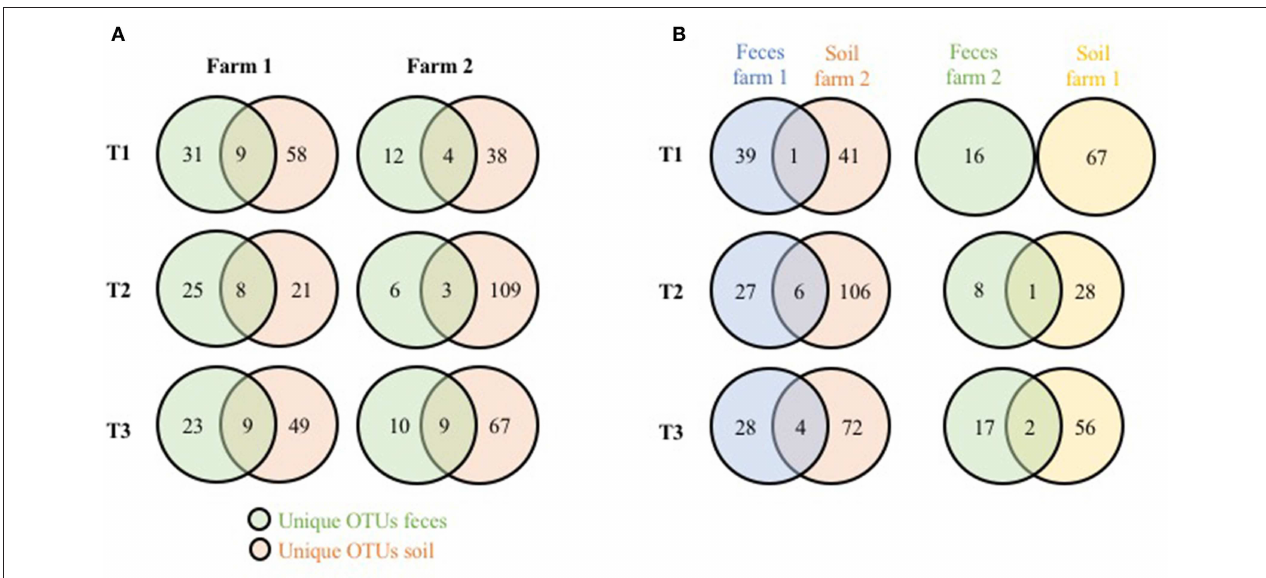
FIGURE 3 | Non-metric multidimensional scaling (NMDS) based on Bray–Curtis dissimilarities of bacterial community composition from cecal (blue) and pre-storage WCR (red) samples collected in farm 1 (circle) and 2 (triangle) during the on-farm processing stage.